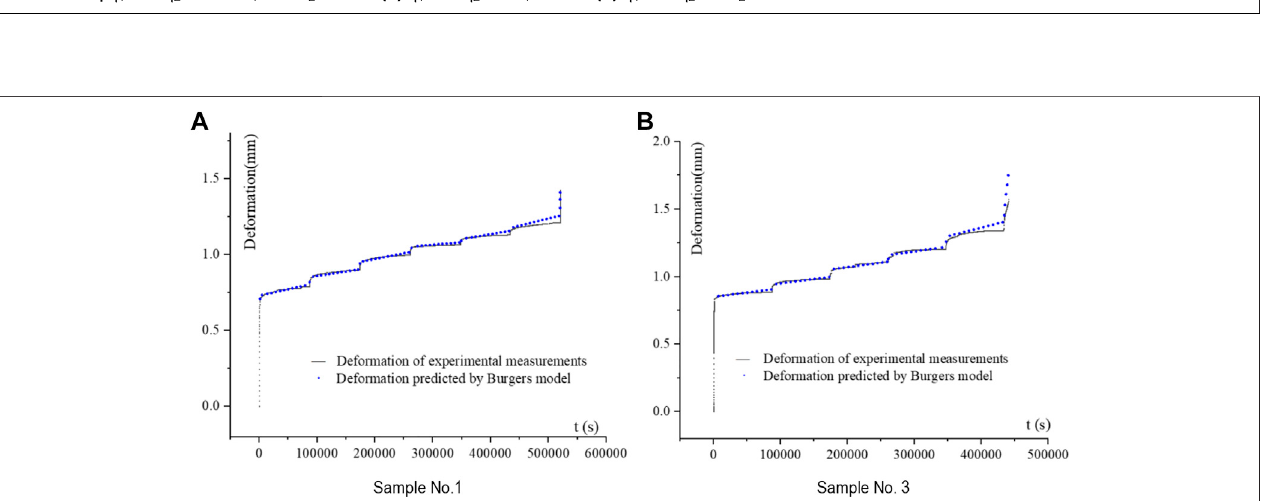
FIGURE 6 | Simulated deformation vs. time relationship using the Burgers Model. (A) Sample No. 1. (B) Sample No. 3.